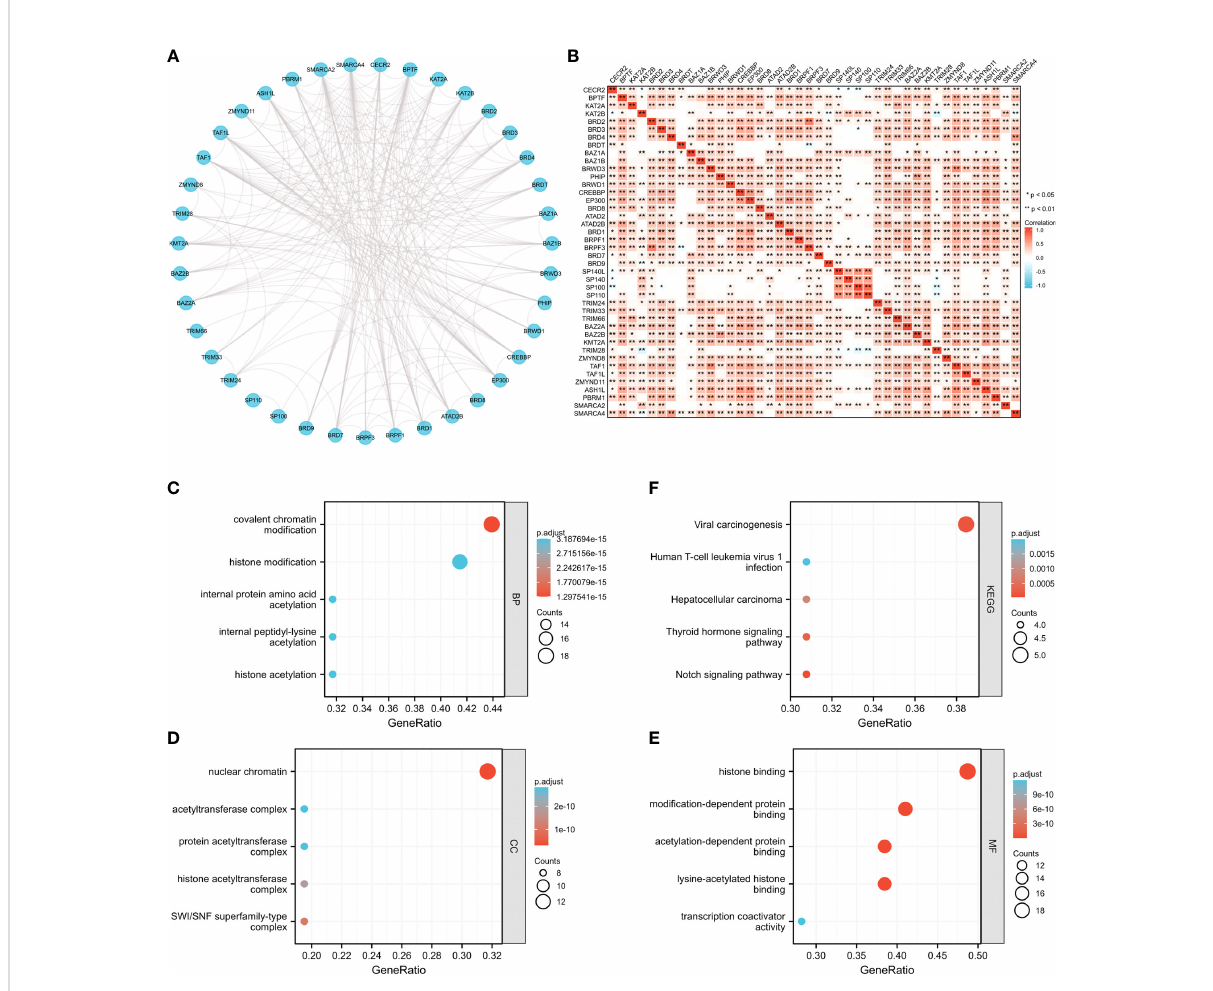
FIGURE 4 The potential molecular functions of BRDs in OSC. (A) PPI network construction for BRDs based on the STRING database. (B) Correlation analysis among the 42 BRGs based on the TCGA database OSC datasets. (C) GO enrichment of BRG genes for BP terms. (D) GO enrichment of BRG genes for CC terms. (E) GO enrichment of BRG genes for MF terms. (F) KEGG enrichment of BRG genes. *p < 0.05; **p <